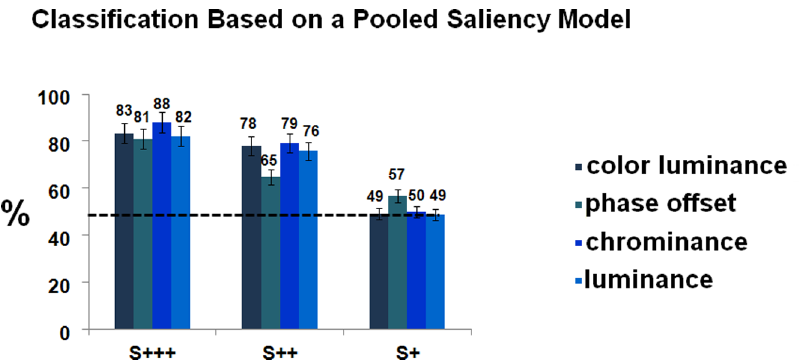
Figure 9. Classification Results Based on a Pooled Saliency Model, in Balanced Accuracy Performance Measures: classification accuracy is proportional to saliency levels. A classification model was built from a pool of all S + /S ++ /S +++ target responses, and used to classify the events of each experiment. Dashed lines depict chance level at 50%. Bars depict confidence intervals for the means at 95%.